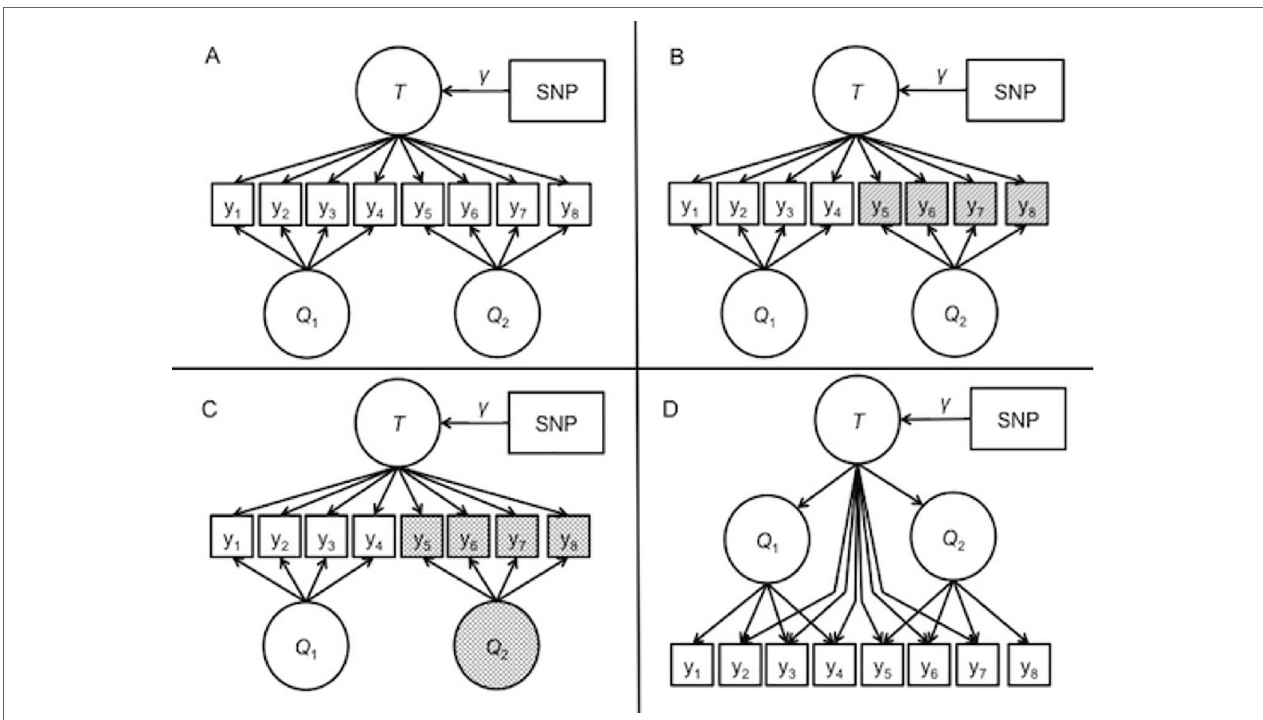
FIGUre 2 | Path diagrams of the data-generating models for the simulation. T represents the general trait. Q 1 and Q 2 are the specific factors corresponding to questionnaire 1 and questionnaire 2, respectively. (A) depicts model 1, representing the ideal measurement case with equal reliabilities for both questionnaires. (B) depicts model 2, in which the items on the second questionnaire have lower reliabilities than the first questionnaire, represented by shading. (C) depicts model 3, in which the Q 2 factor is shaded, representing an increased mean and variance along with reliability differences. (D) depicts model 4, a second-order model where the general factor summarizes the covariance among two questionnaire-specific factors, and the general factor additional direct effects on select